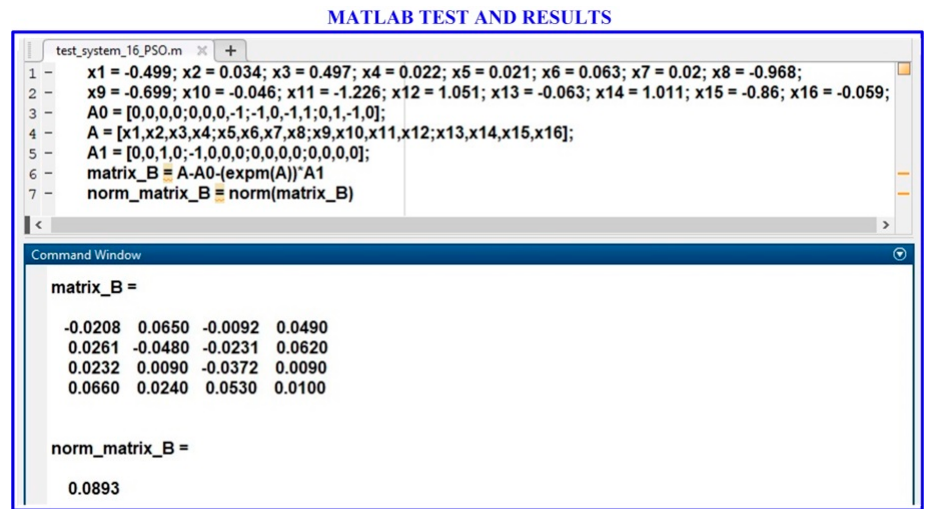
Figure A3. MATLAB test and results based on PSO algorithm optimization for transcendental matrix equation with dimension = 4.